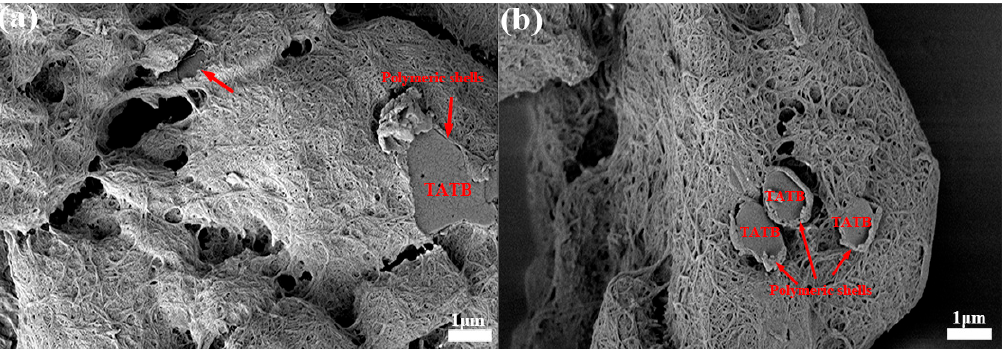
Figure 3. SEM images for polymeric shells with glycidyl azide polymer (GAP) grafting ( a ) and polytetramethylene ether glycol (PTMEG) ( b ).